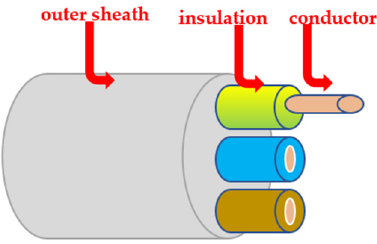
Figure 8. Schematic of a 3-conductor cable sample.